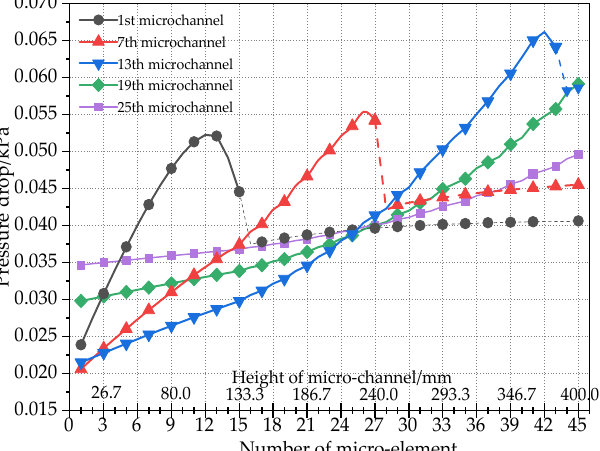
Figure 11. Pressure drop change in the refrigerant with the number of micro-elements. To analyze the pressure drop in the two-phase and superheated regions, the pressure drop in the two-phase and superheated regions for all microchannels were calculated, as shown in Figure 12. From Figure 12, it can be seen that for the 1st microchannel, the two-